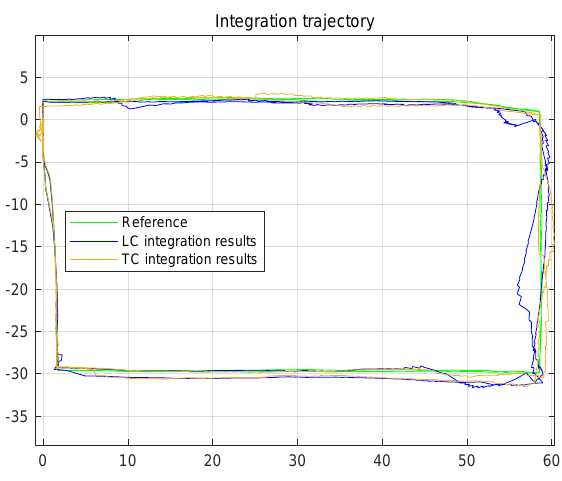
Figure 4: The integrated navigation results of track 1.